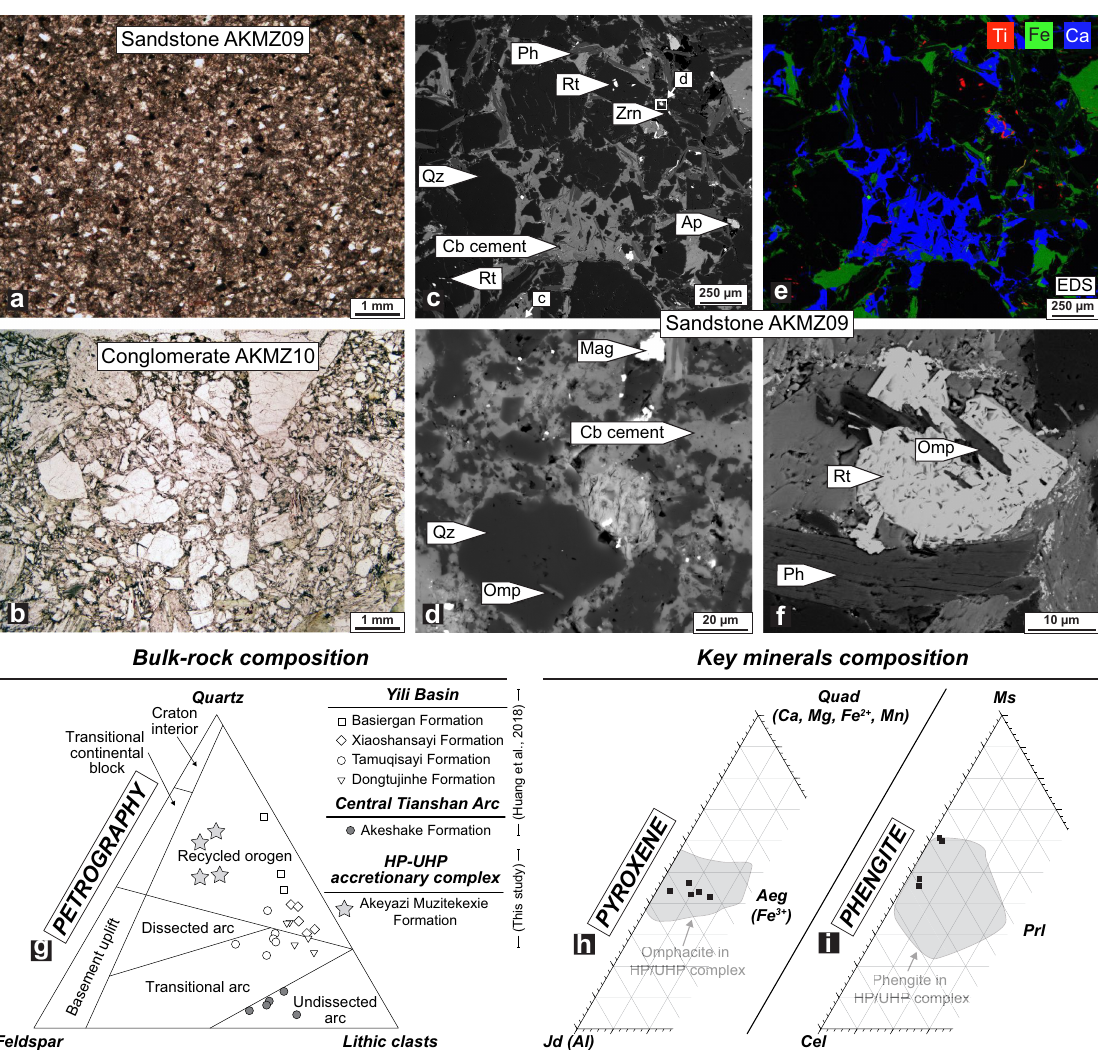
Fig. 2 Petrographic features of the MFAB sandstone. a Triassic sandstones and b conglomerates in the MFAB. c , d , f BSE images and e SEM-EDS mapping show the preservation of high-pressure mineral relics (i.e., Rt, Ph, and Omp) in detritus; mineral abbreviation is following ref. 128 . g Sandstone petrographic data for studied samples including Q-F-L 129 (quartz, feldspar, and lithic clasts). h , i Mineral composition of phengite and omphacite relics found in studied